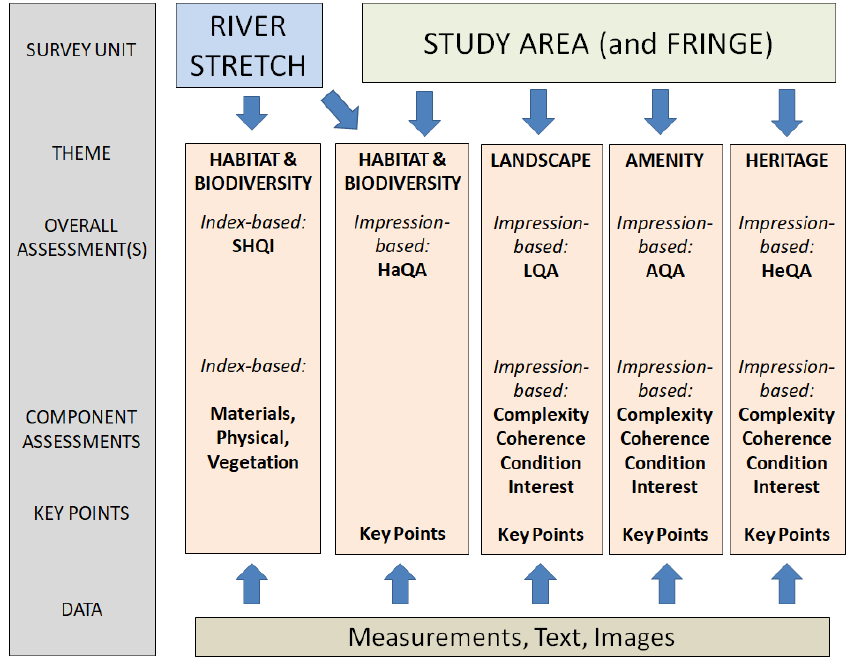
Figure 3. Conceptual flow diagram showing the structure of the PlaceMarker Survey and